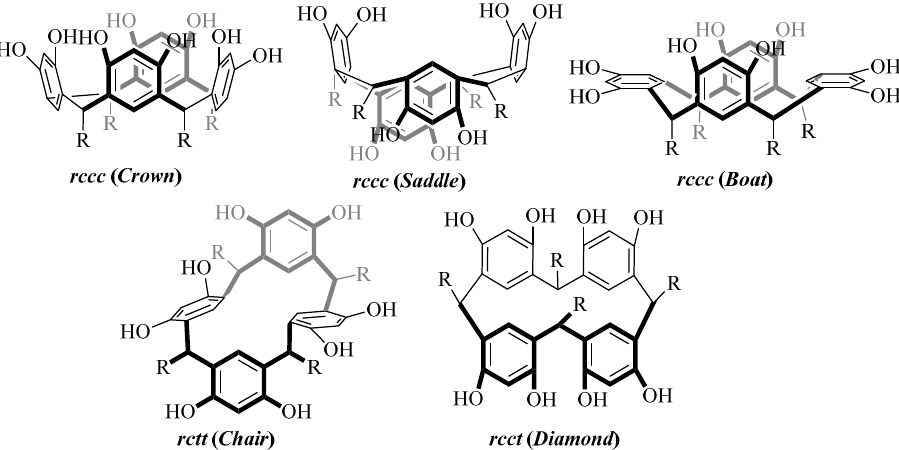
Figure 1. Reported conformational isomers, according to the relative configuration of the substituents in the methylene bridges.